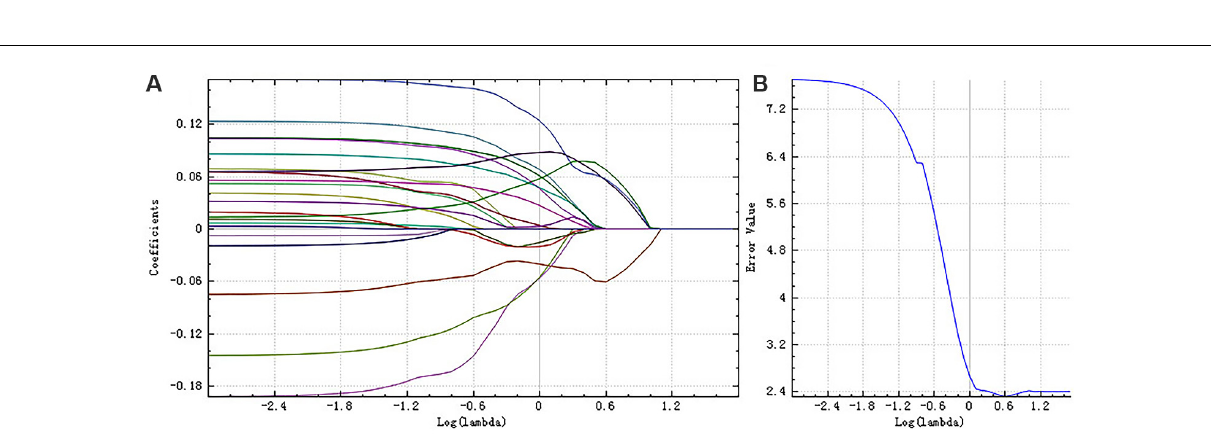
FIGURE 5 | The coefficients-lambda graph (A) and the error-lambda graph (B) of the left hippocampus. We chose the λ corresponding to the lowest error rate.